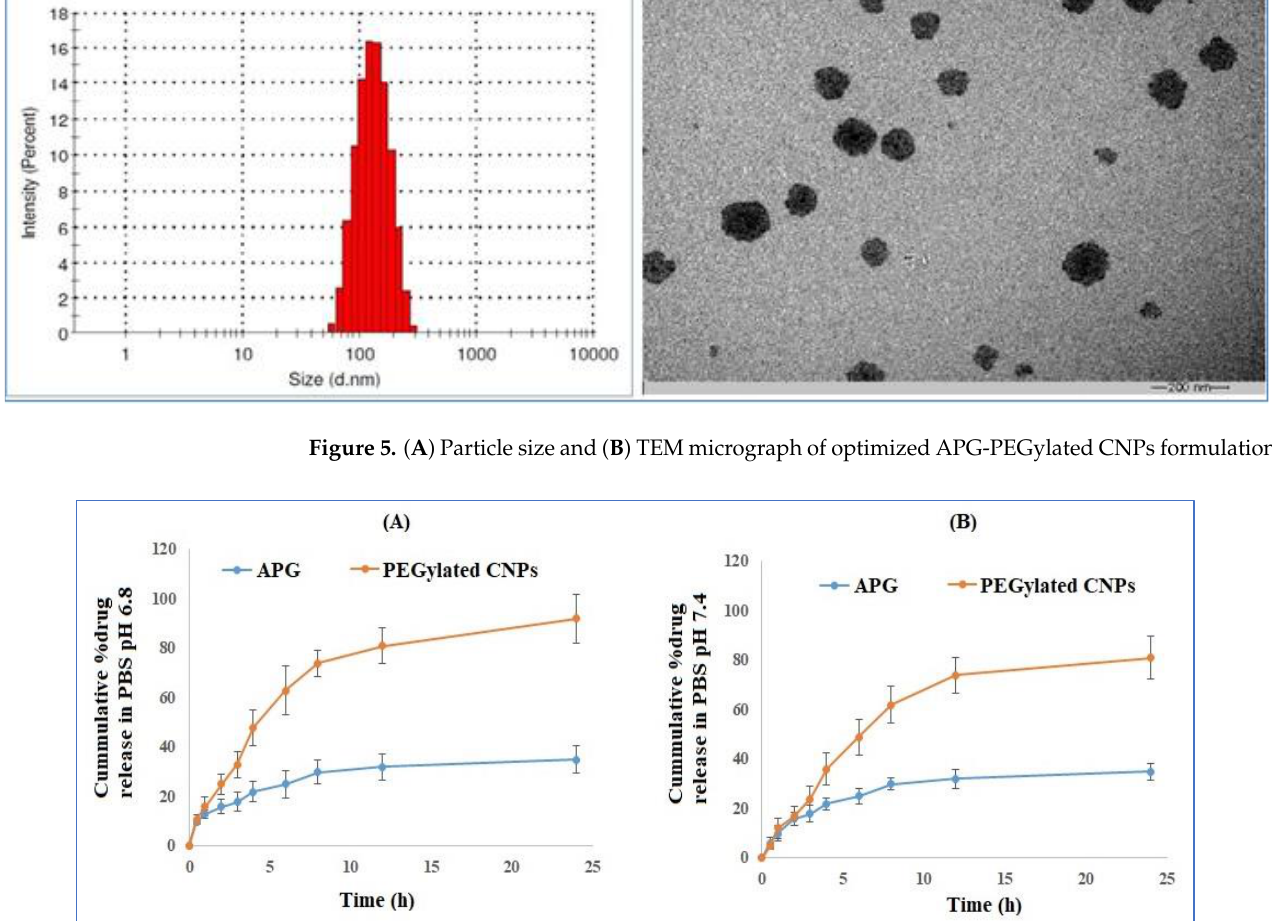
Figure 5. ( A ) Particle size and ( B ) TEM micrograph of optimized APG-PEGylated CNPs formula- tions.